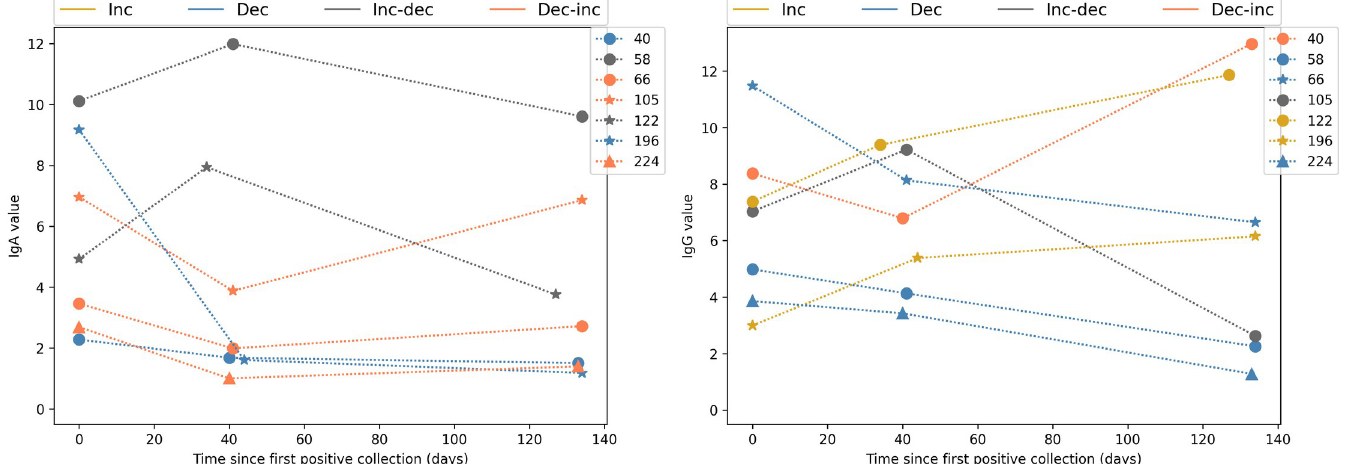
Fig 11. (a) IgA and (b) IgG series of values for subjects with three samples starting with a positive one. Colors denote different behaviors: increasing (yellow), decreasing (blue), increasing-decreasing (gray), decreasing-increasing (orange).